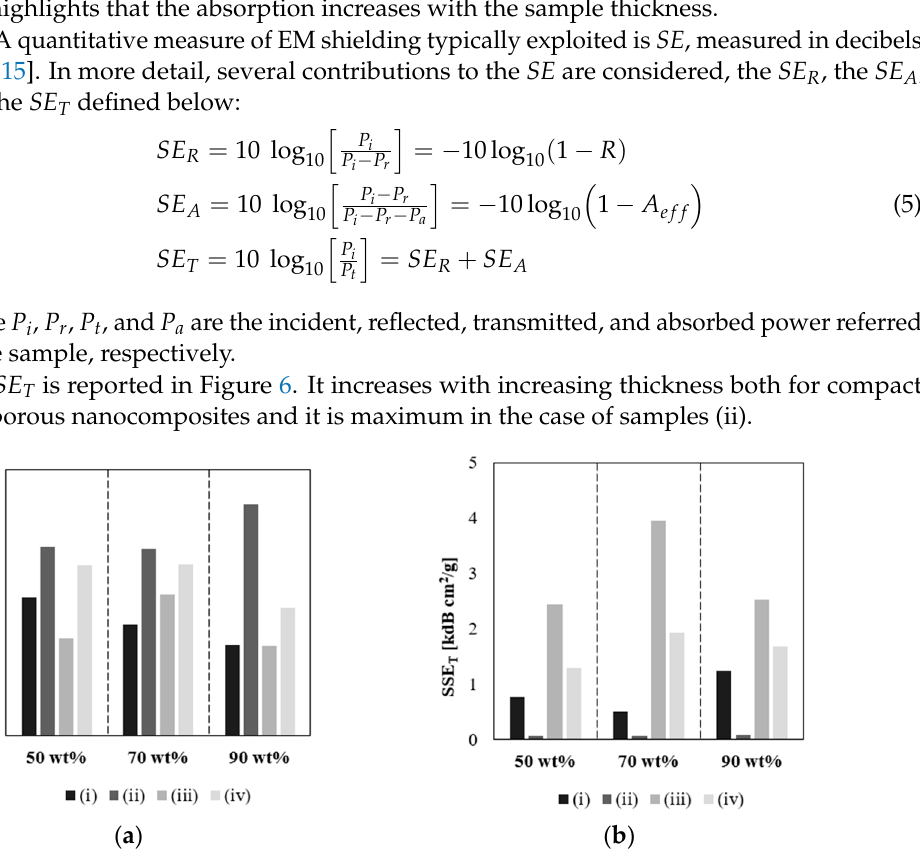
Figure 6. SE T ( a ) and SSE T ( b ) at 10 GHz for samples with 50 wt%, 70 wt%, and 90 wt% GNP contents.